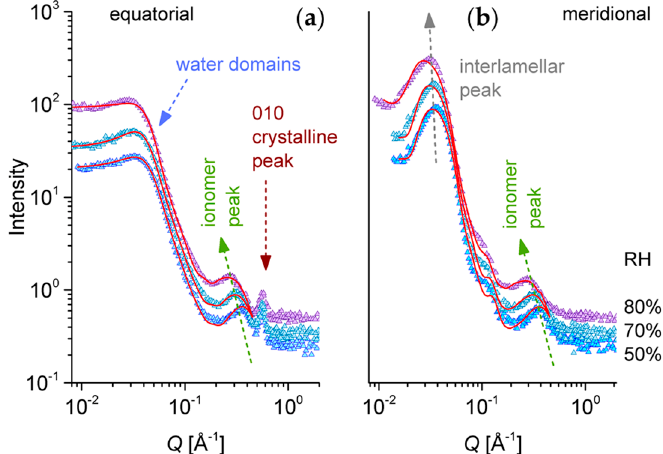
Figure 6. One-dimensional SANS patterns from the high sulfonated s-sPS film containing the co-crystalline δ -phase with protonated toluene and loaded with C70 fullerenes hydrated at different RH levels. Experimental data (symbols) averaged over the equatorial ( a ) or meridian ( b ) directions are shown separately, with the lines corresponding to the model interpretation of the scattering profiles, as discussed in text. The main structural features and their behavior with the variation of RH are indicated.